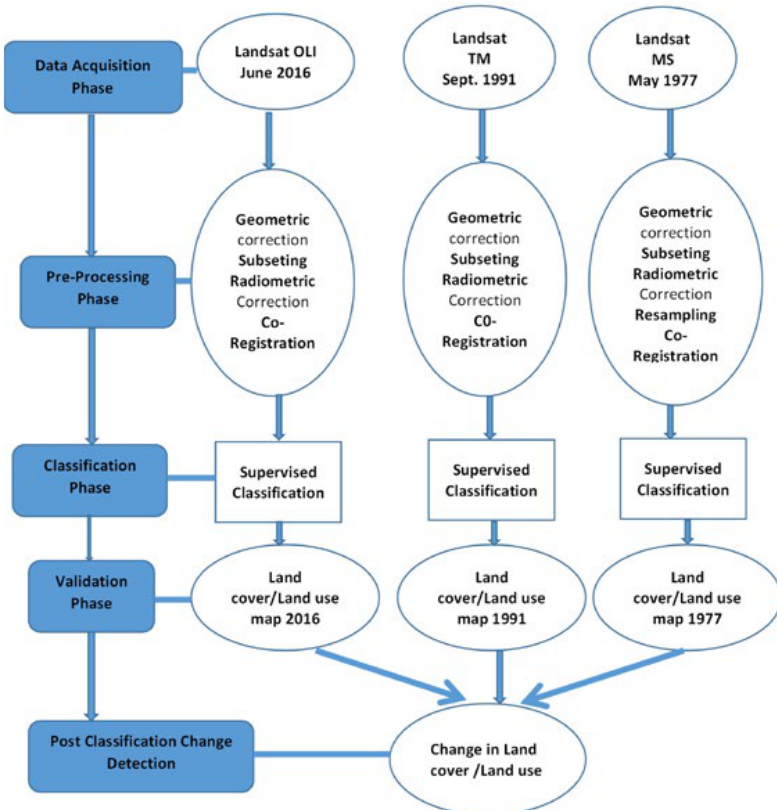
Fig. 2: A graphical display of the methodology used in the study